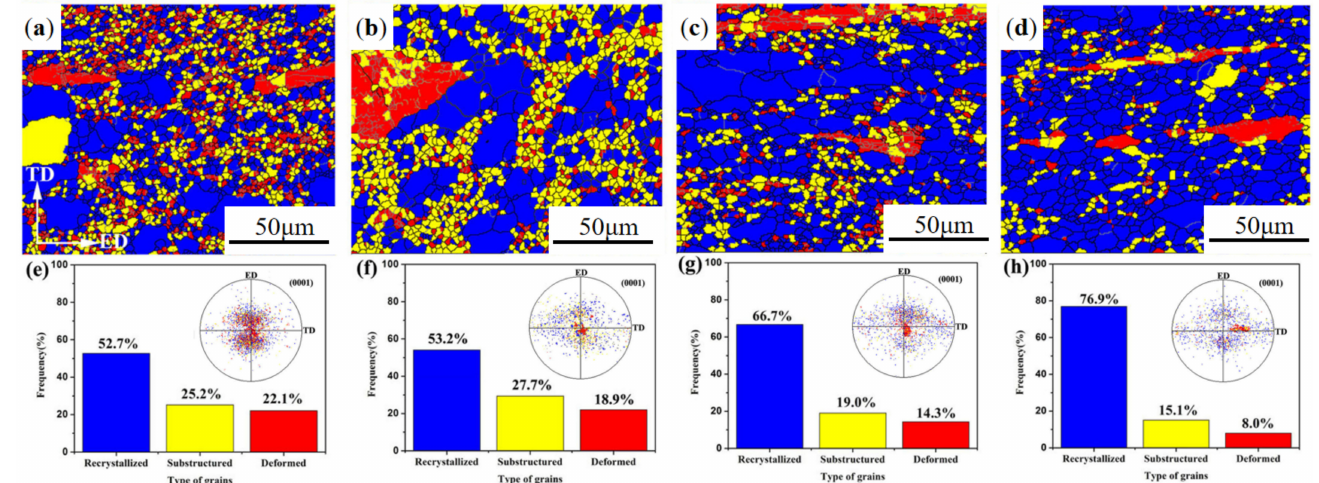
Figure 9. Different types of grains in the as-extruded ( a ) TX10 alloy; ( b ) TXZ100 alloy; ( c ) TXZ101 alloy; ( d ) TXZ102 alloy: blue—recrystallized, yellow—substructure, red—deformed; ( e – h ) frequency and corresponding (0001) pole figures of the different types of grains shown in ( a ), ( b ), ( c ), and ( d ), respectively. (In this figure, R is recrystallized, S is substructured, and D is